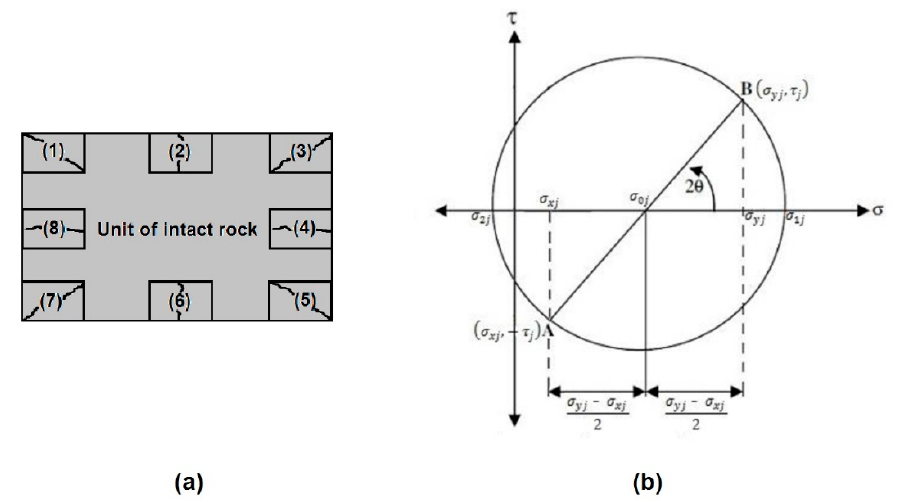
Figure 5. Diagonal traction failure: ( a ) locations of all eight nodes considered, ( b ) stress representa- tion.